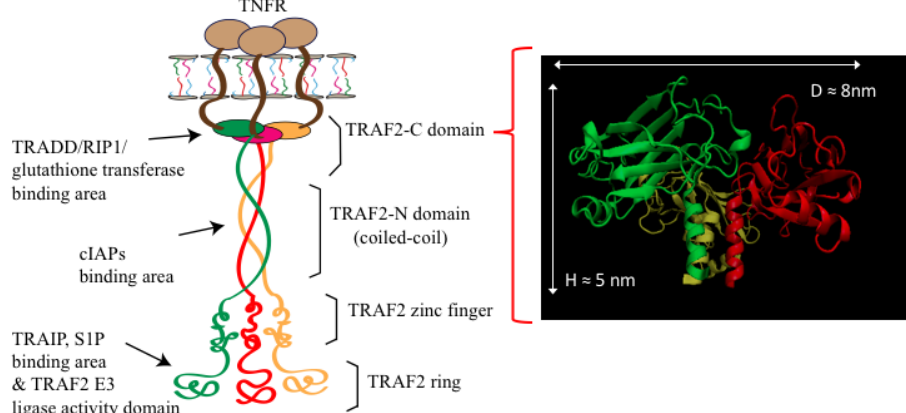
Figure 1. Left: Schematic representation of the TNFR-membrane-TRAF2 system. The receptor is sketched in brown, while the three TRAF2 subunits are shown in green, red, and orange. The protein domains and the main binding areas and ligand proteins are also indicated. Right: Crystallographic model of TRAF2-C is shown (pdb: 1CA4).